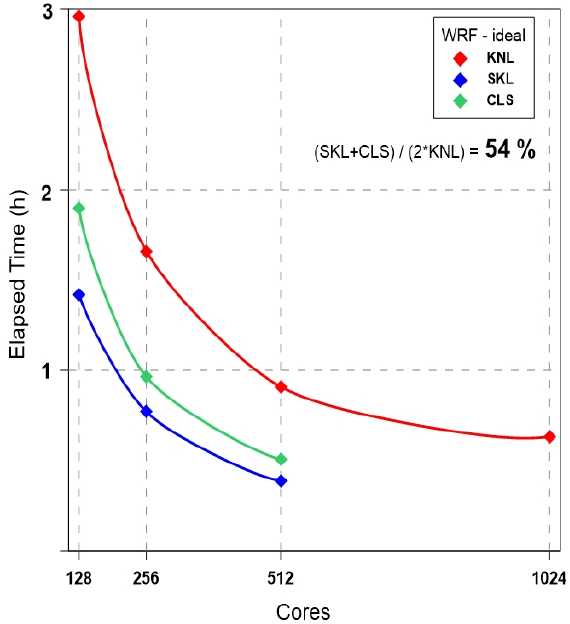
Figure 2. WRF-Large Eddy Simulation (LES) performances with respect to the number of cores for an ideal experiment: (SKL + CLS) / (2*KNL) =